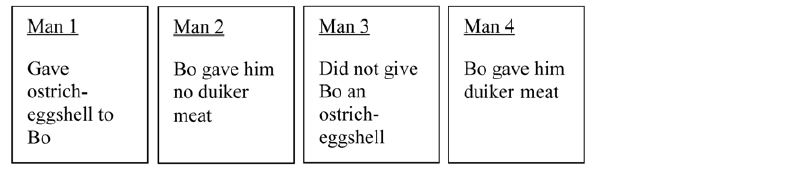
Figure 1. The scenario of the descriptive and social contract version.